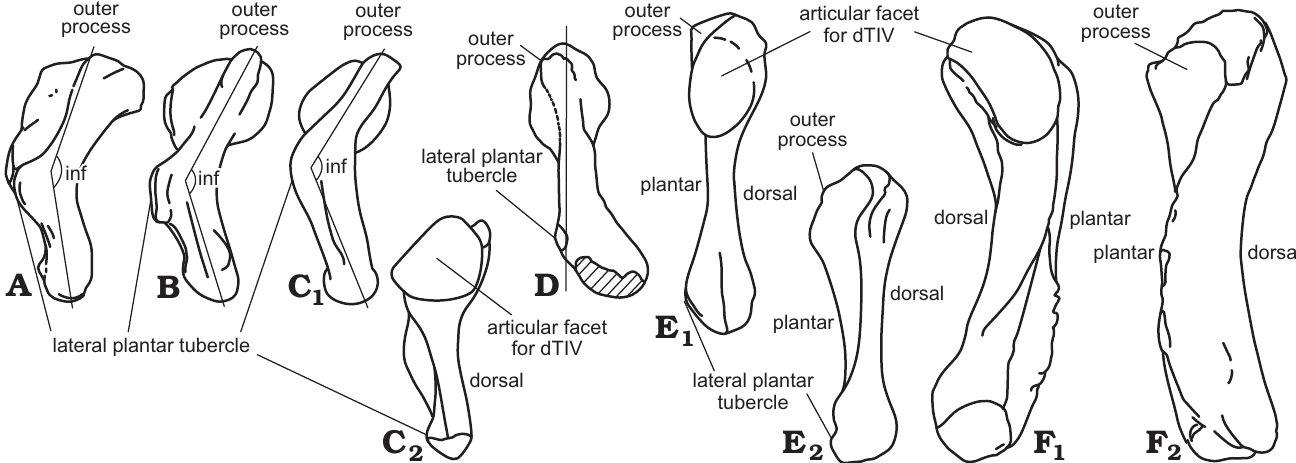
Fig. 2. Comparison of fifth metatarsal architecture. Right bones in lateral view (A, B , C 1 , D, E 2 , F 2 ) and in medial view (C 2 , E 1 , F 1 ). A . Iguana iguana (Linnaeus, 1758), Iguanidae, Recent. B . Sphenodon punctatus (Gray, 1842), Rhynchocephalia, Recent. C . Sophineta cracoviensis Evans and Borsuk- Bia ł ynicka, 2009, Lepidosauromorpha, Early Triassic, Poland. D . Gephyrosaurus bridensis Evans, 1980, Rhynchocephalia, Early Jurassic, South Wales, UK; straight line approximates not-inflacted shape of the MttV. E . Morphotype X, Early Triassic, Poland (left MttV reversed). F . Osmolskina czatko- wicensis Borsuk-Bia ł ynicka and Evans, 2003, Archosauriformes, Early Triassic, Poland. inf, inflection angle. Not to scale. A, B after Robinson (1975); D, after Evans